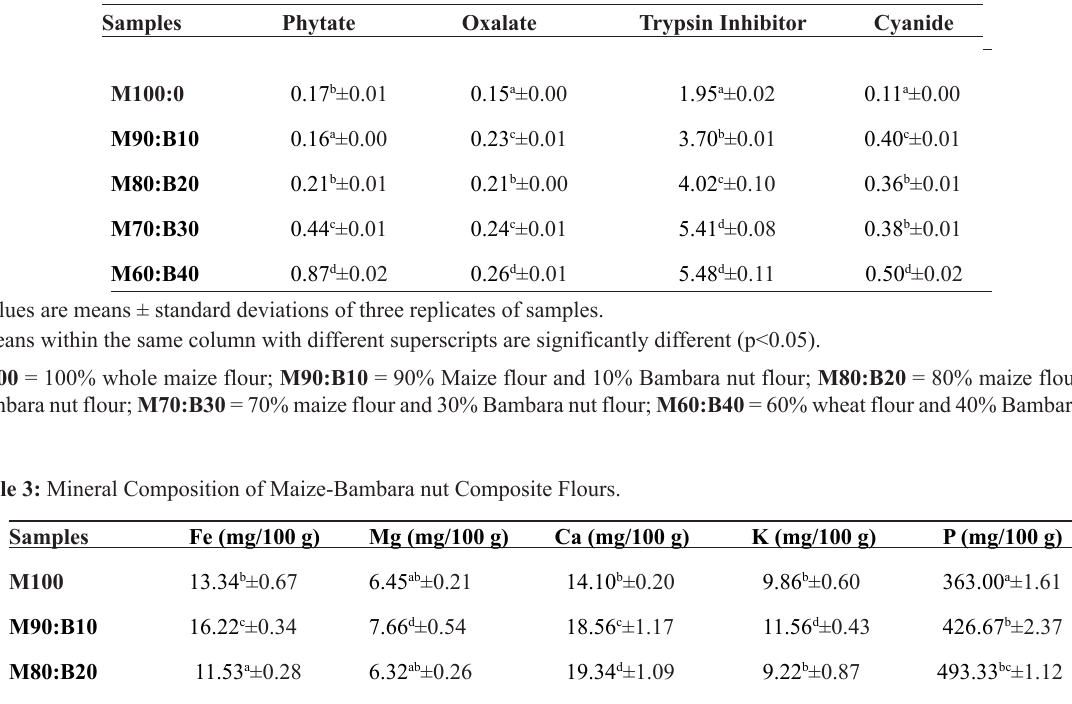
Table 2: Anti-nutritional Factors of Maize-Bambara nut Composite Flours mg/100 g.